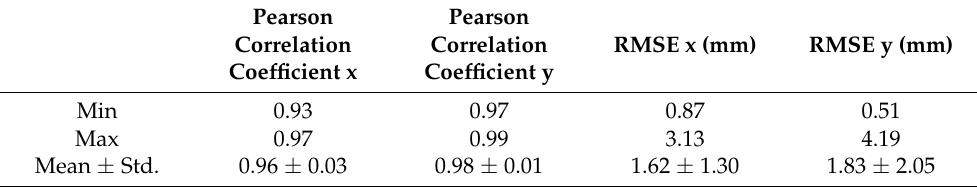
Figure 4. Centre of pressure validation force plate vs. developed sensor system example test runs. Table 1. Pearson correlation coefficient and root mean square error for centre of pressure